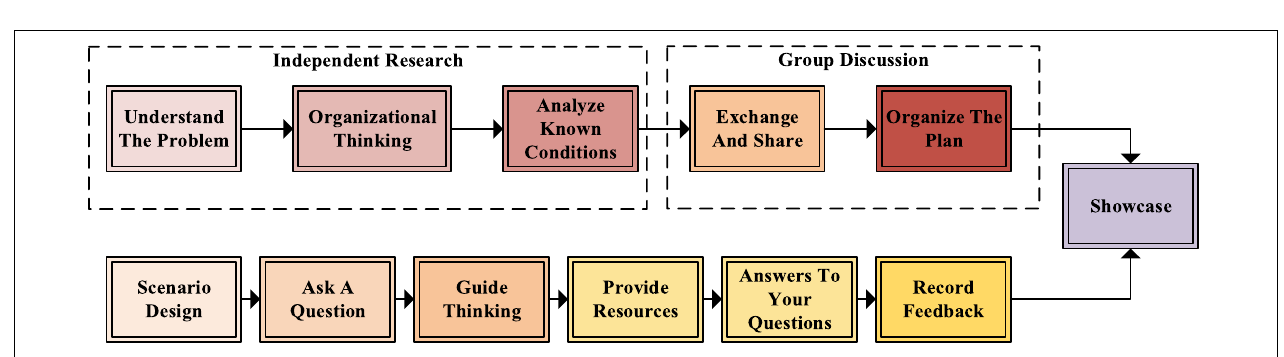
FIGURE 1 | The traditional shallow learning process.